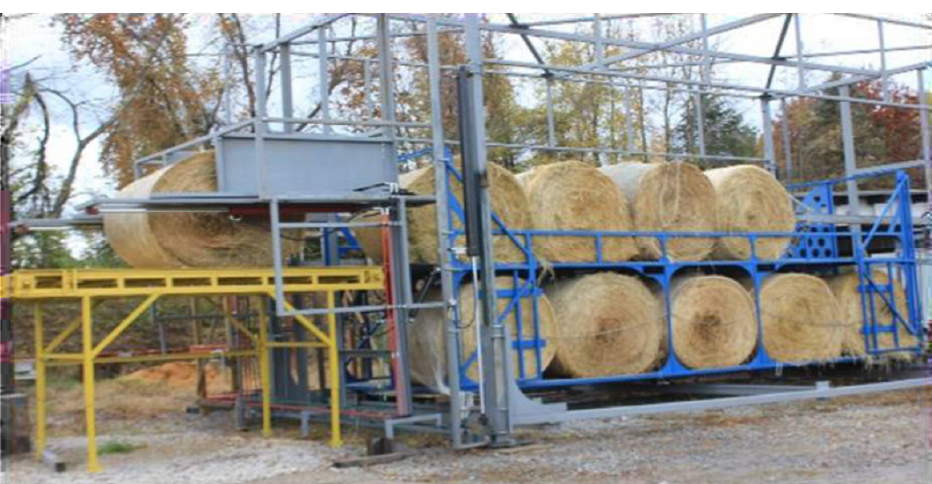
Figure 3. Rack unloader shown unloading bales from top tier chambers.